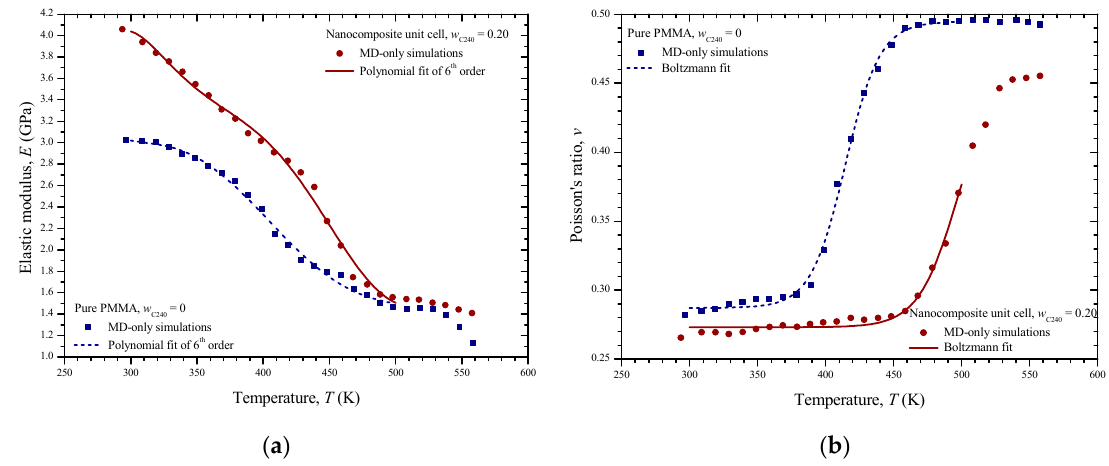
Figure 11. The ( a ) elastic modulus and ( b ) Poisson ratio of the pure PMMA and the nanocomposite with w C240 = 0.2 with respect to the temperature and corresponding nonlinear fittings up to 500 K.